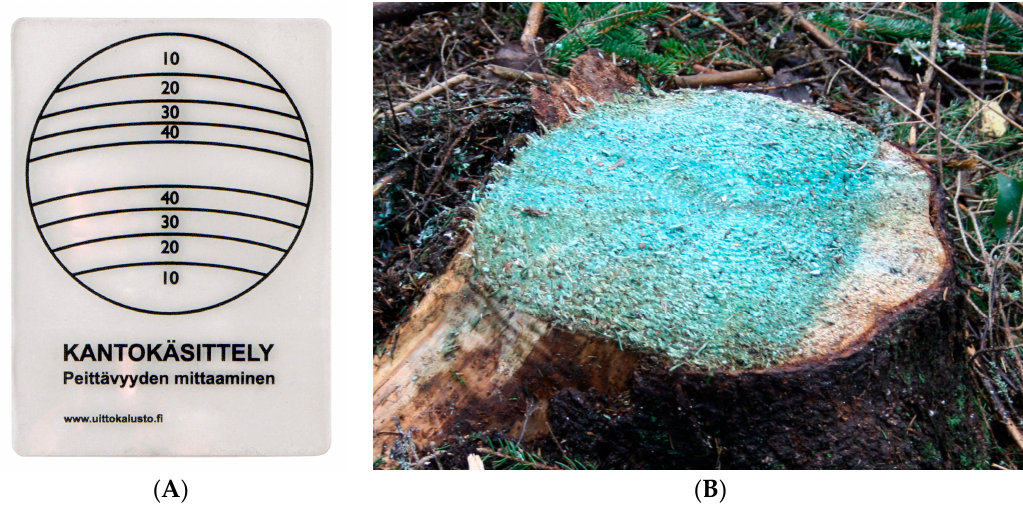
Figure 3. ( A ) A transparent measuring plate used in the study. By changing the distance of the transparent measuring plate above the stump, the focal length is selected by combining the edges of the stump and the ring of the measuring plate. Based on the relative proportions of the plate, it is possible to determine the relative proportion of the uncovered area of the stump surface. Photo courtesy of Uittokalusto Ltd. ( B ) The stump with the uncoverage rate of around 11–13% (not the blue area). Photo courtesy of Kalle Kärhä.